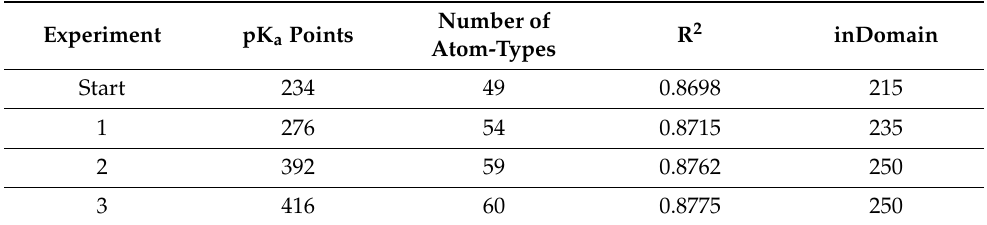
Table 1. Results of the matrix solving via QR decomposition. R 2 is the coefficient of determination, which captures the variance caught by the model. Number Experiment pK a Points